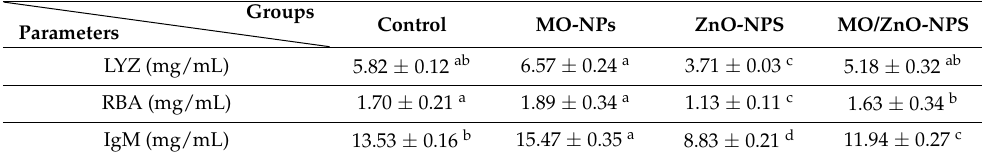
Table 6. Changes in immunological parameters (mean ± SD) of Nile tilapia , O. niloticus exposed to ZnO-NPs with MO leaves nanoparticles administration for 2